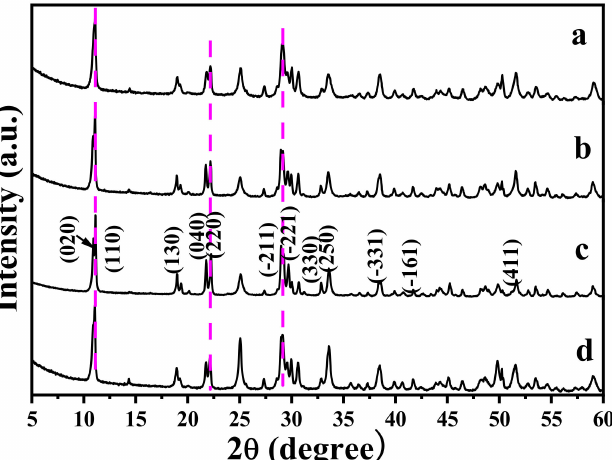
Figure 2. XRD patterns of MC- R M, with ( a ) R = 0.25, ( b ) R = 0.5, ( c ) R = 1.0, and ( d ) R =1.5.